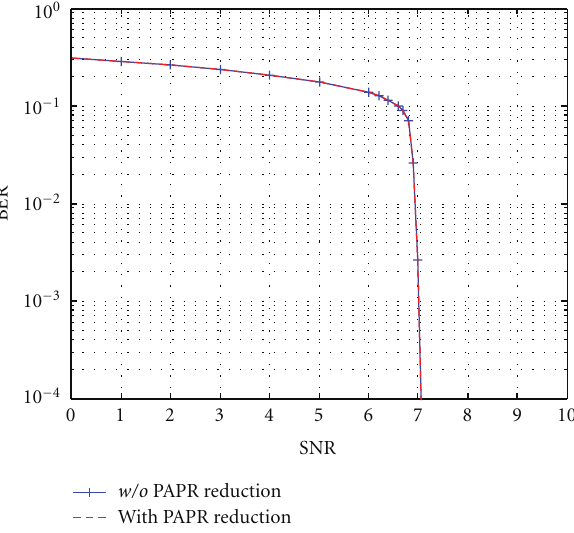
Figure 18: MSE of channel coe ffi cients estimation, 2K mode, 16- QAM modulation, and F1 channel [1].